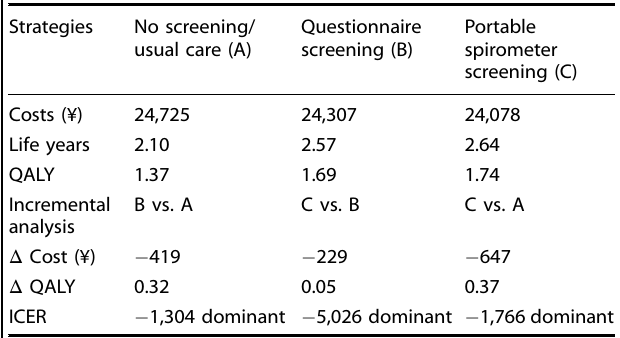
Table 1. Base case analysis results over a lifetime horizon. Strategies